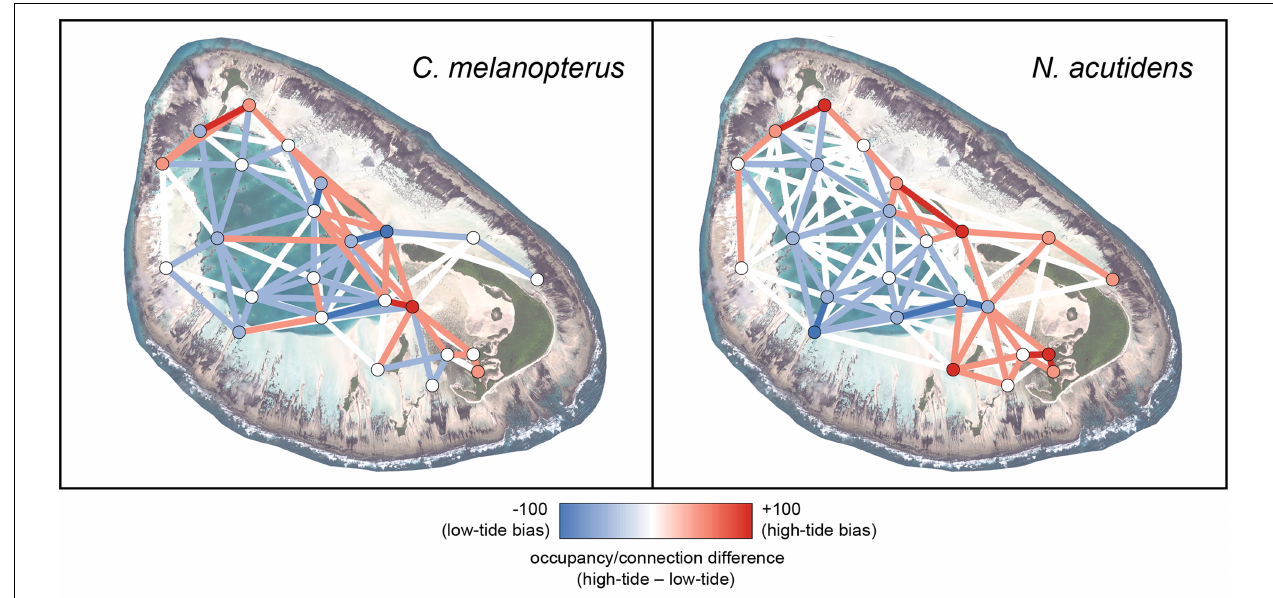
FIGURE 3 | Relative 1-hour difference networks showing how space use differs between high ( > 1.4 m) and low ( < 1.4 m) tides for blacktip reef shark Carcharhinus melanopterus and sicklefin lemon shark Negaprion acutidens . Each difference has been calculated as the metrics of the high-tide network minus those for the low-tide network; red denotes more high tide use, blue more low tide use. The satellite image of St Joseph was acquired from LAND INFO Worldwide Mapping, LLC (Denver CO, United States), and includes material Copyright DigitalGlobe (Longmont, Colorado). The maps were produced using ArcGIS (ESRI Inc., CA, United